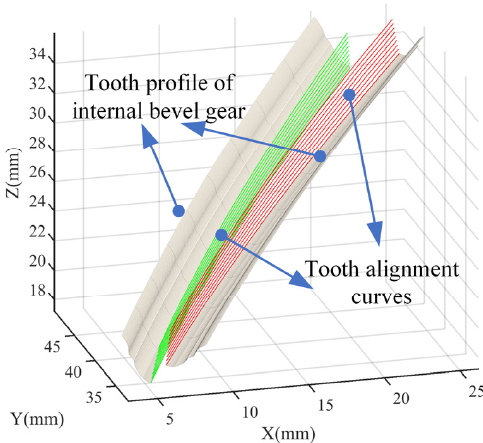
Figure 4. The actual tooth alignment curves (3D).